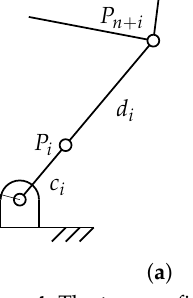
Figure 4. The two configurations of a type-1 singularity for a generic n -RR structure: ( a ) stretched-out; ( b )